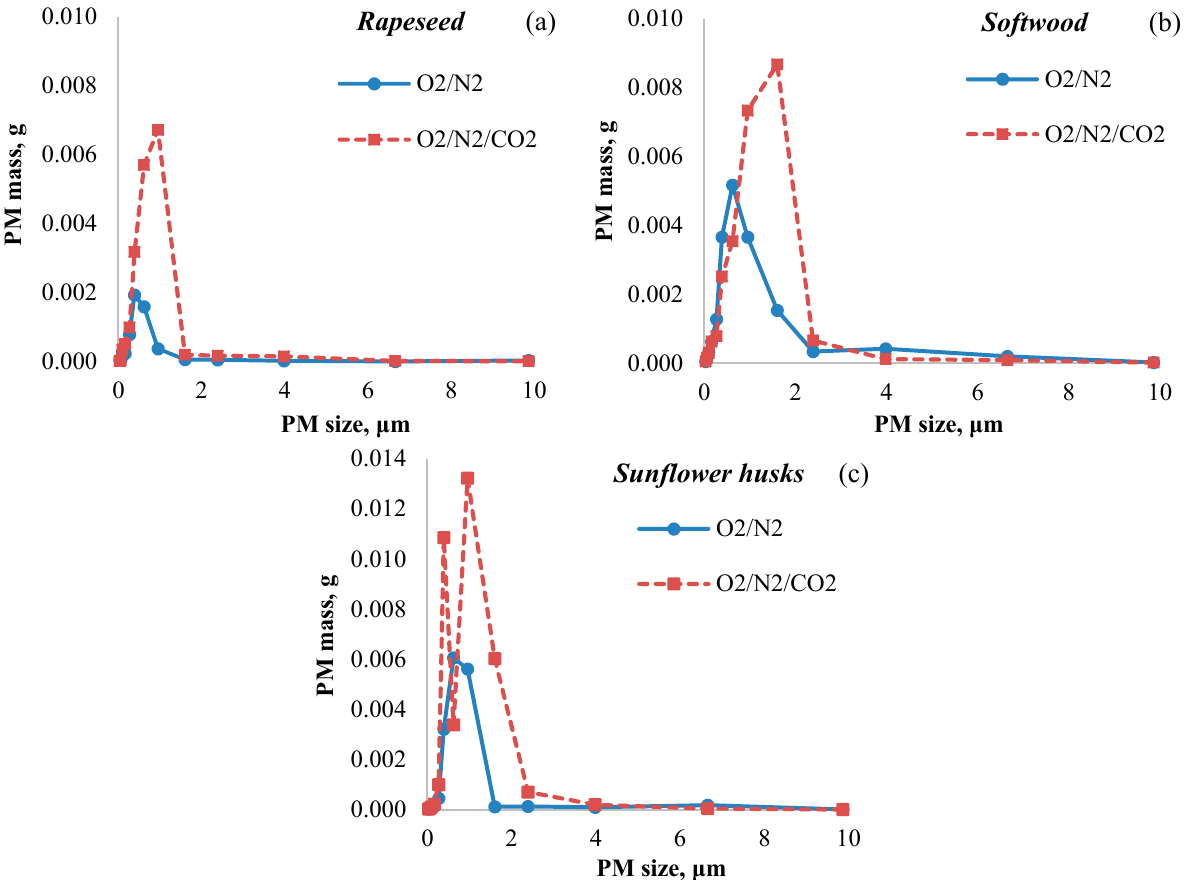
Figure 5. Effect of the gasifying agent on PM size and mass distribution for the different biomass ( a ) rapeseed, ( b ) softwood, and ( c ) sunflower husks.